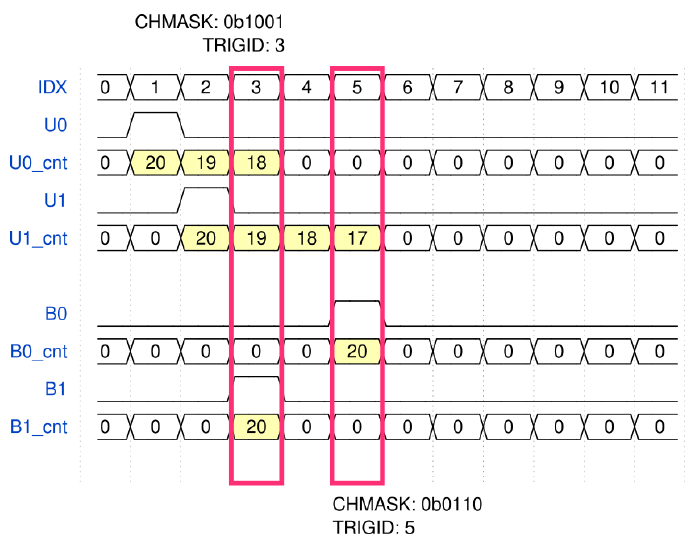
Figure 38. Example data for triggering subsystem of demonstration